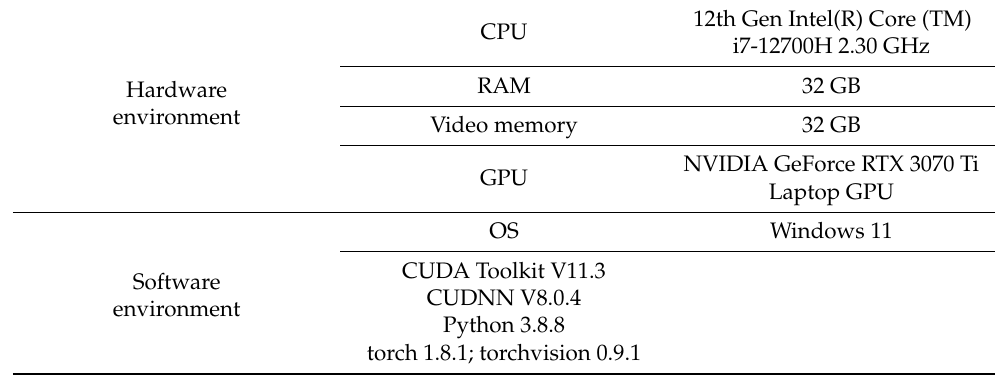
Table 3. Hardware and software parameters.